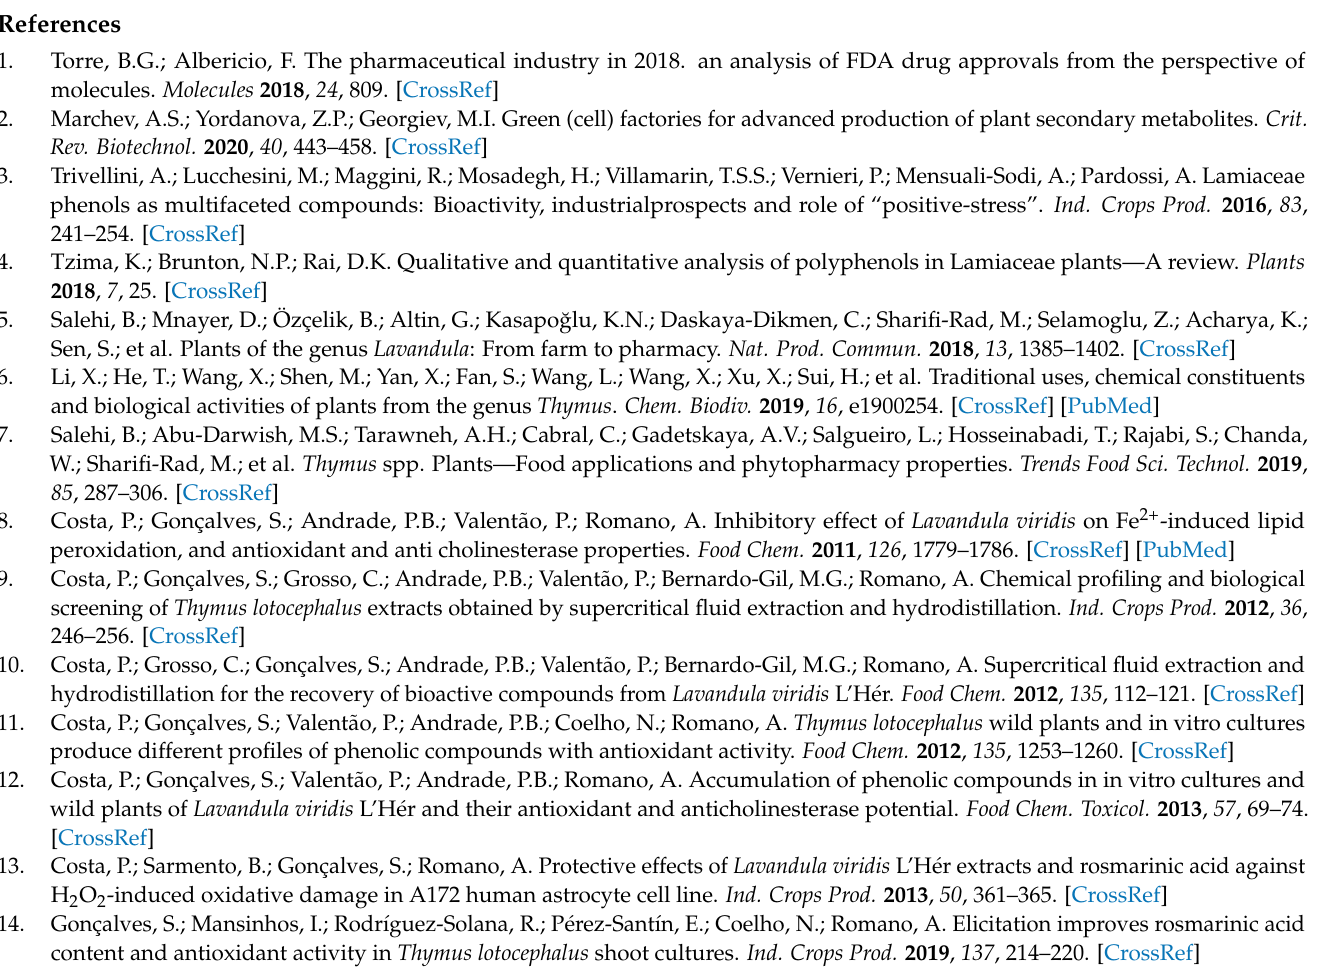
Supplementary Materials: The following are available online. Table S1: HPLC-HR-MS data of R. Morales extracts, Table S2: Summary of HPLC-HR-MS parameters for quantification of phenolic compounds in Lavandula viridis L’H é r and Thymus lotocephalus G. Lopez and R. Morales